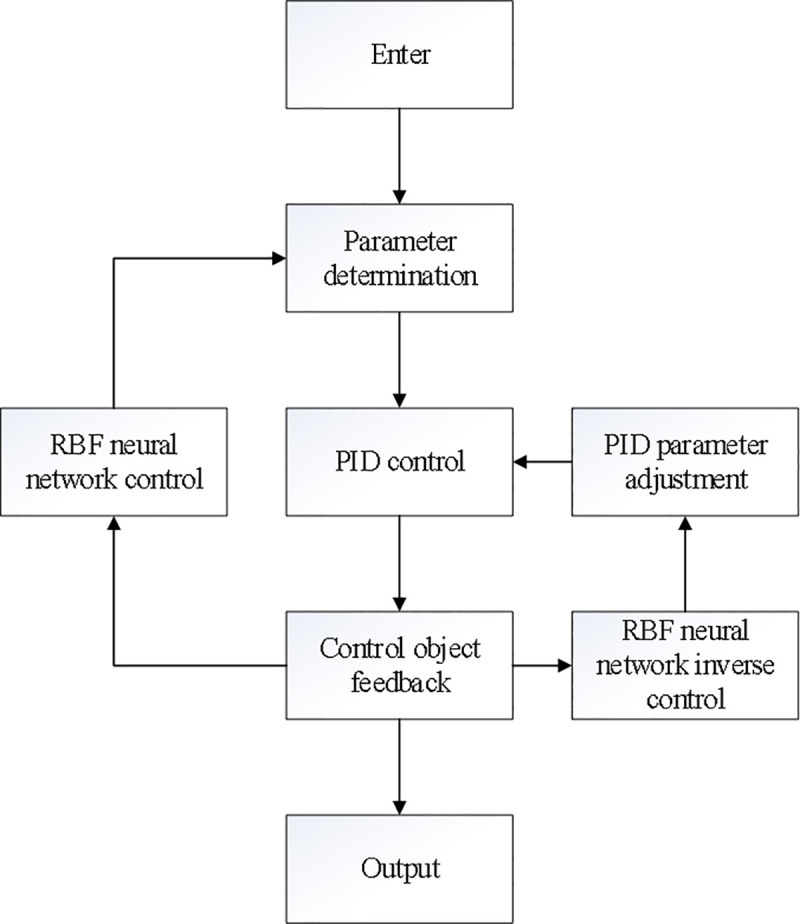
Control idea of hybrid bearing system.